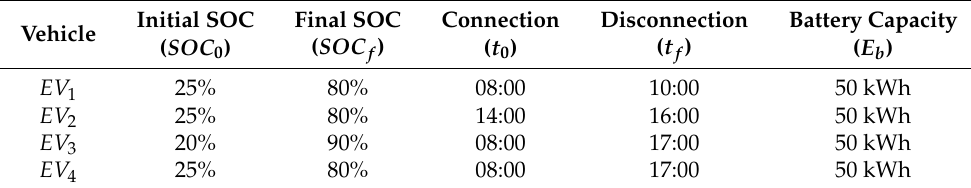
Table 4. User parameters of the electric